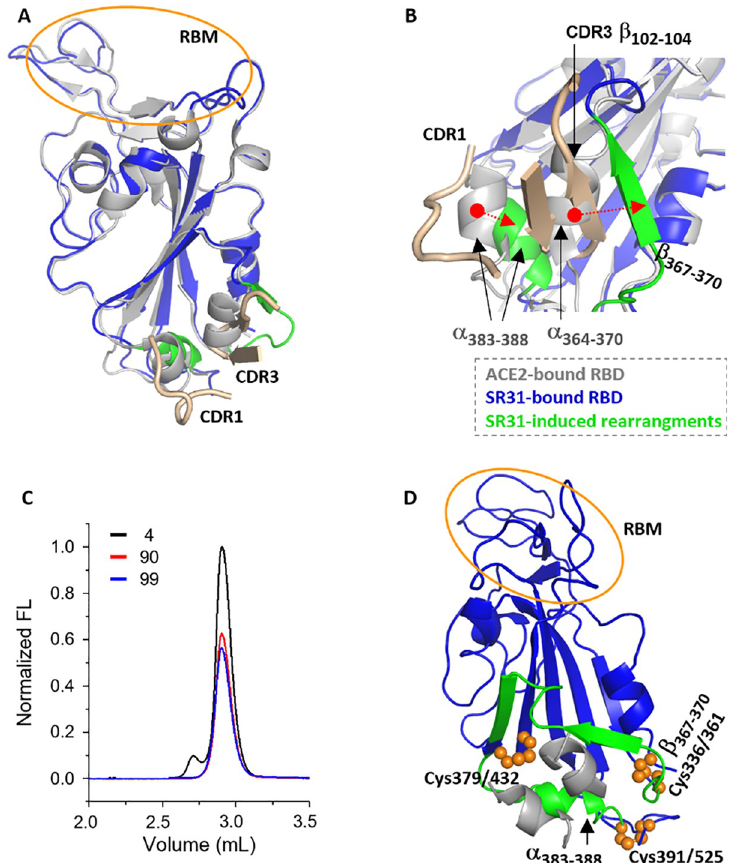
Fig 4. SR31 causes dramatic structural arrangements of RBD at the binding site without distorting the receptor- binding motif. ( A, B ) The overview ( A ) and expanded view ( B ) of the comparison between the ACE2-bound RBD (grey) and SR31-bound RBD (blue). SR31-binding deforms the RBD at the binding site (green) but not at the RBM region (yellow circle). The two SR31 CDRs involved in the deformation are colored wheat. In B , two structural rearrangements (green) are shown at a different angle. The α 383–388 helix in the ACE2-bound form is pushed towards the RBD core, and the short helix α 364–370 is transformed into a β -strand ( β 367–370 ) which forms a parallel β -sheet with β 102–104 from SR31 CDR3. ( C ) An indirect stability assay of the RBD using fluorescence-detection size exclusion chromatography. The RBD was incubated at 4˚C (black), 90˚C (red), and 99˚C (blue) for 20 min before loaded onto an analytical column for gel filtration. The retention profile of RBD was monitored by intrinsic tryptophan fluorescence. The void volume is 1.9 mL and the total volume is 4.5 mL. The chromatogram beyond 3.5 mL (not displayed) only showed background-level fluorescence. ( D ) Three disulfide bonds (orange spheres) segregate the two motifs ( α 383–388 and β 367–370 , green) from the RBM (orange cycle). α 383–388 is tethered between Cys379/432 and Cys391/525; β 367–360 is tethered between Cys379/432 and